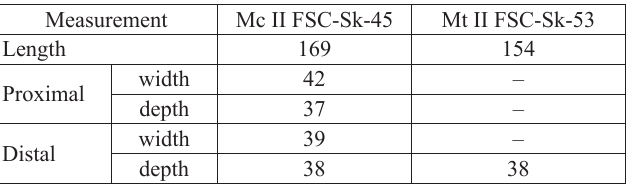
Table 2. Measurements (in mm) of Eoazara xerrii gen. et sp. nov. post